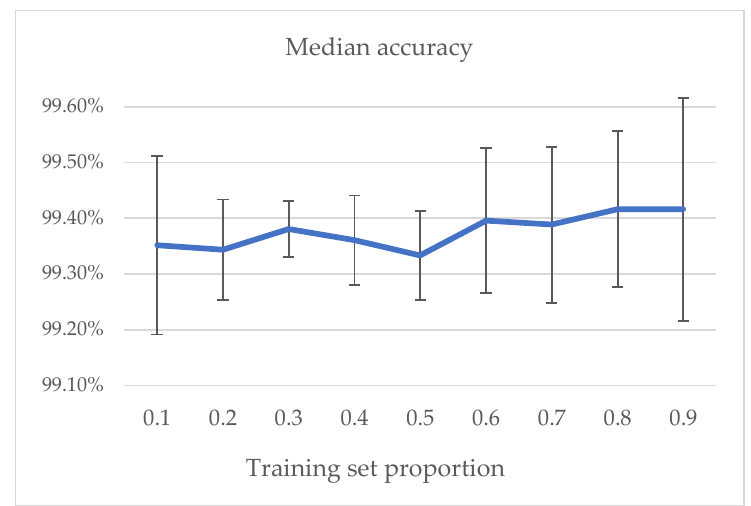
Figure 11. Median accuracy of different validation methods on the LFW test set.